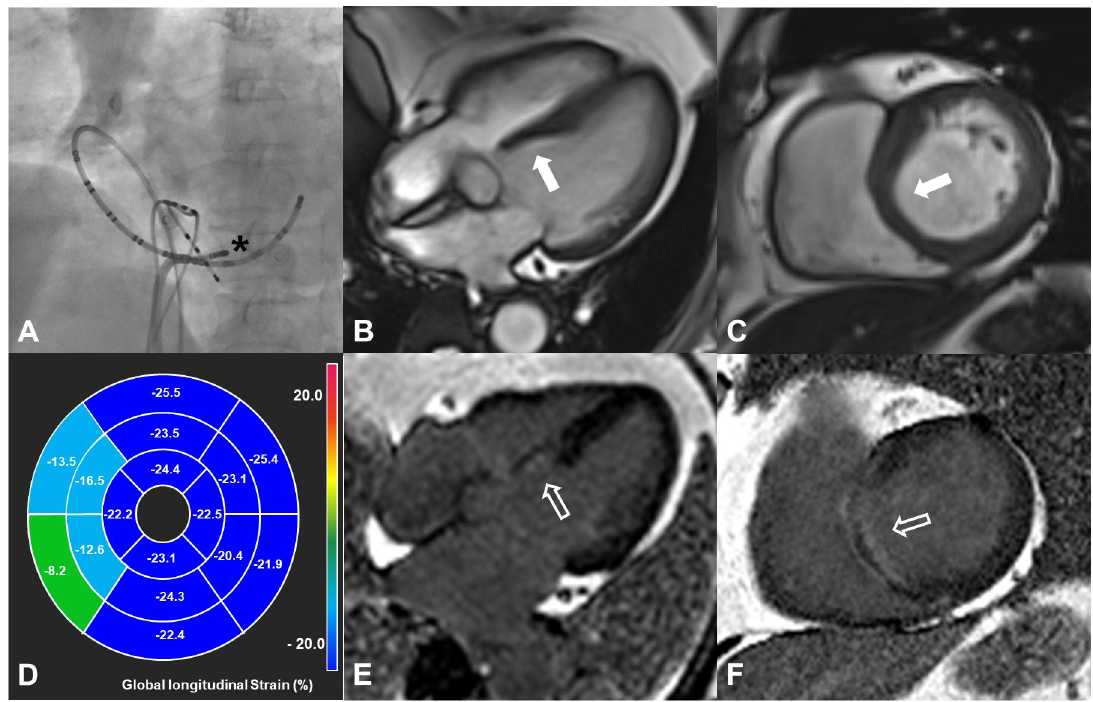
Fig 4. A 67-year-old female patient with Wolff-Parkinson-White syndrome. She underwent an electrophysiologic study due to frequent palpitations. Radiofrequency ablation was applied to the posteroseptal accessory pathway through the transseptal approach (asterisk) (A). One year later, the patient underwent cardiac magnetic resonance imaging. Four-chamber and short-axis cine images show regional myocardial wall thinning (about 5.1mm) at the basal inferior septum on the end-diastolic phase (arrows) (B, C). Decreased global longitudinal strain is noted at the basal septum with the feature tracking method, which suggests regional akinesia (D). The left ventricular ejection fraction is 47.6%. Linear endocardial and epicardial late gadolinium enhancements not corresponding with the vascular territory are noted on the four-chamber and short-axis late gadolinium enhancement images (open arrows) (E, F).